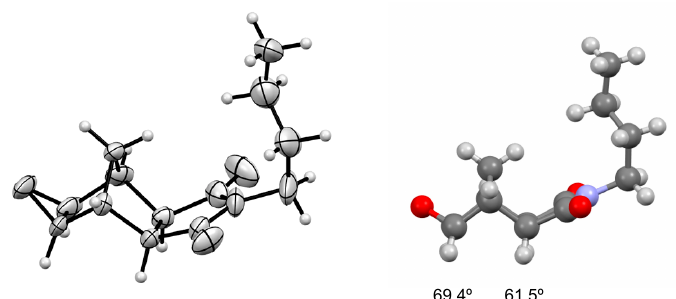
Figure 2. Molecular structure of 3 (thermal ellipsoids at 50% level) and side view showing angles of 3- and 5-membered rings to norbornane core.